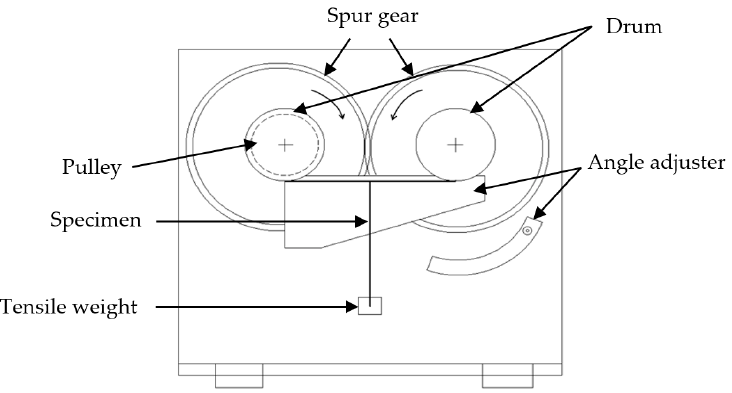
Figure 3. T-peel test apparatus schematic diagram.